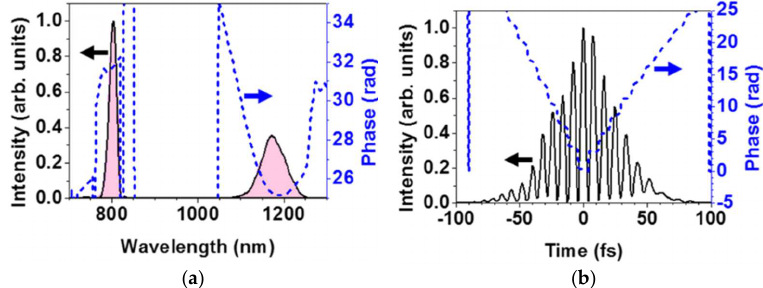
Figure 9. ( a ) Spectral and ( b ) temporal intensity profiles (solid line) and phases (broken line) of the test pulse retrieved from the XFROG trace.